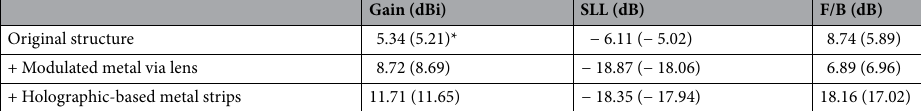
Table 2. The effect of adding manipulating components to the original structure on the radiation characteristics. *The simulated (measured) results at f = 30